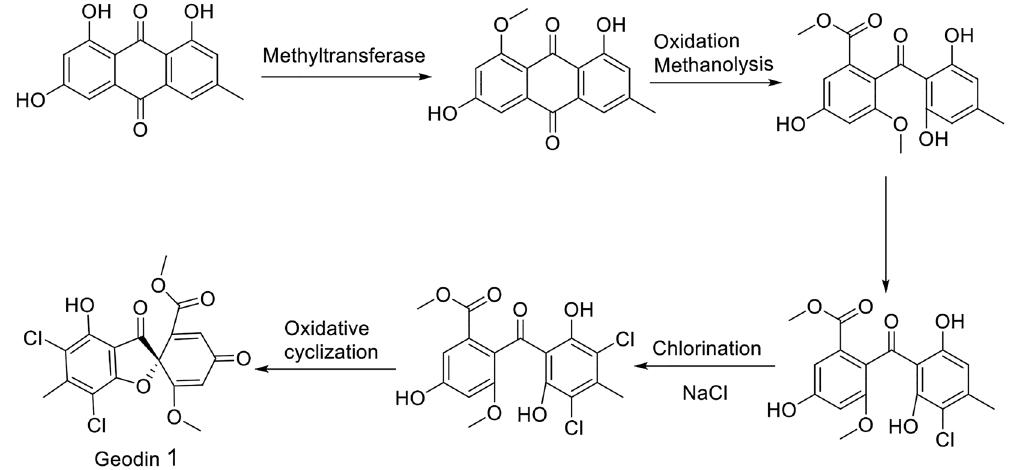
Figure 3: Biosynthetic pathway of natural product geodin 1